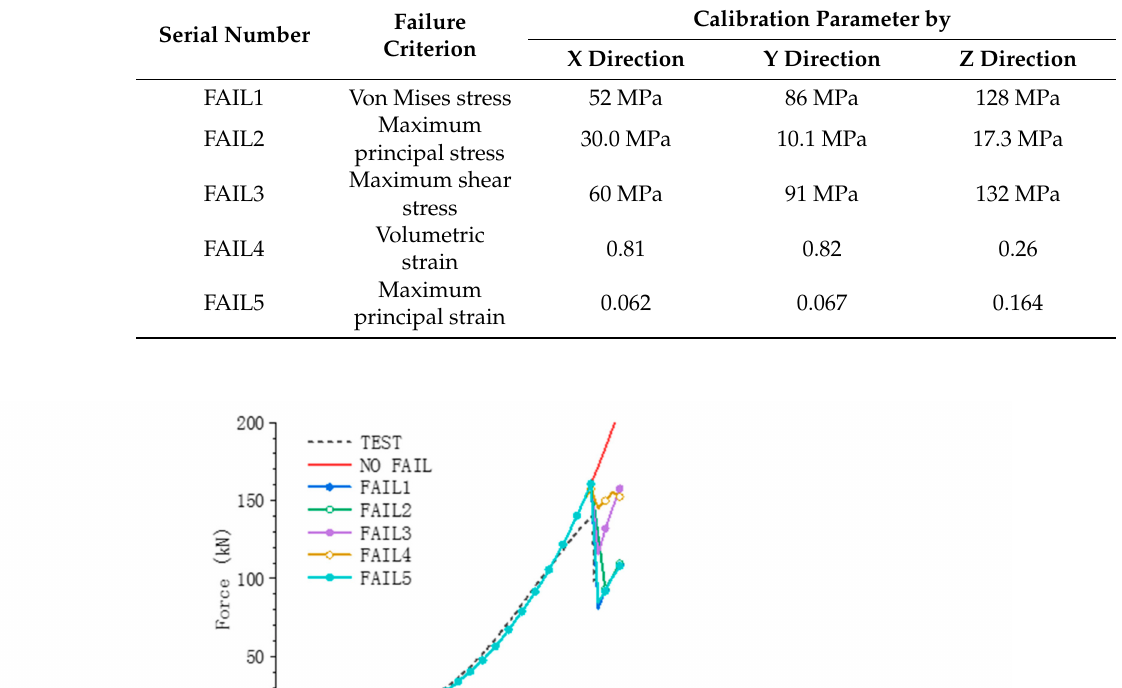
Table 2. Single-parameter failure criteria and their formulations considered in the study.